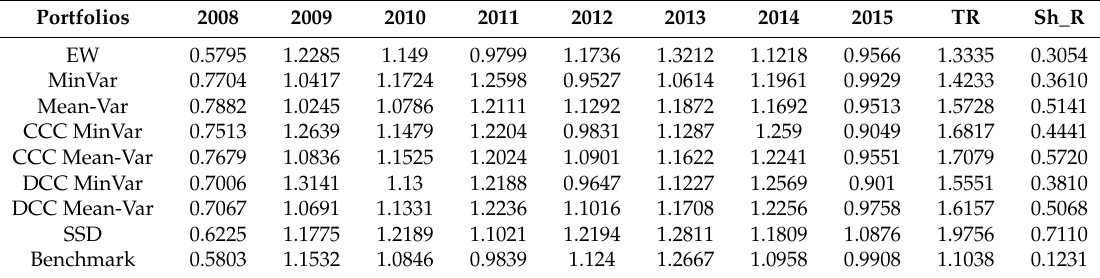
Table 6. Yearly compounded returns, Total compounded Return (T_R) and Sharpe Ratio (Sh_R) for S&P 100 stocks (t = 1000).